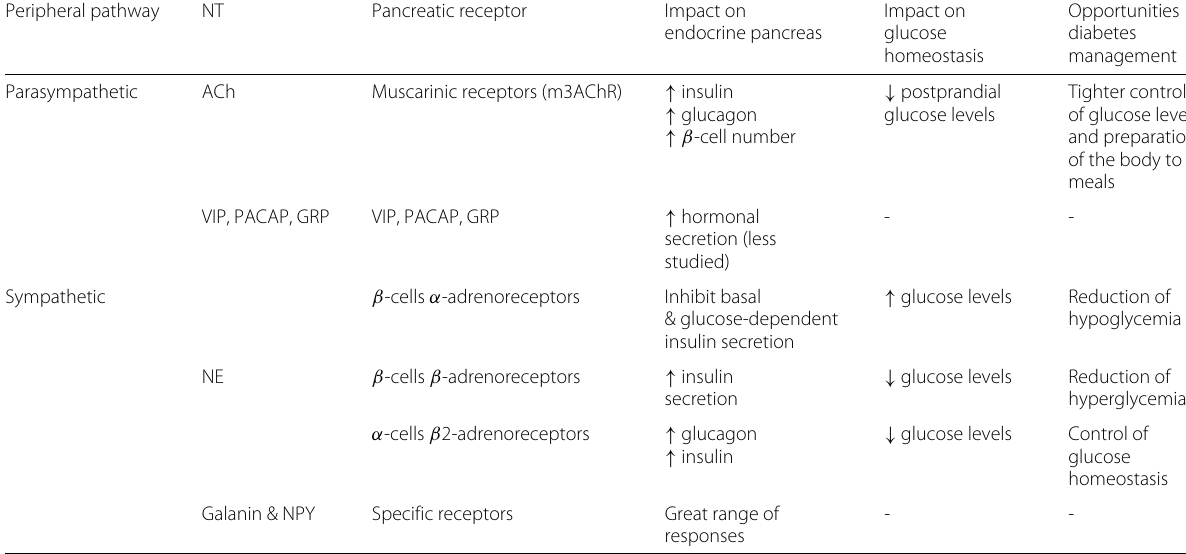
Table 2 Peripheral pathways involved in pancreatic secretion and benefit of modulating them for diabetes management Peripheral